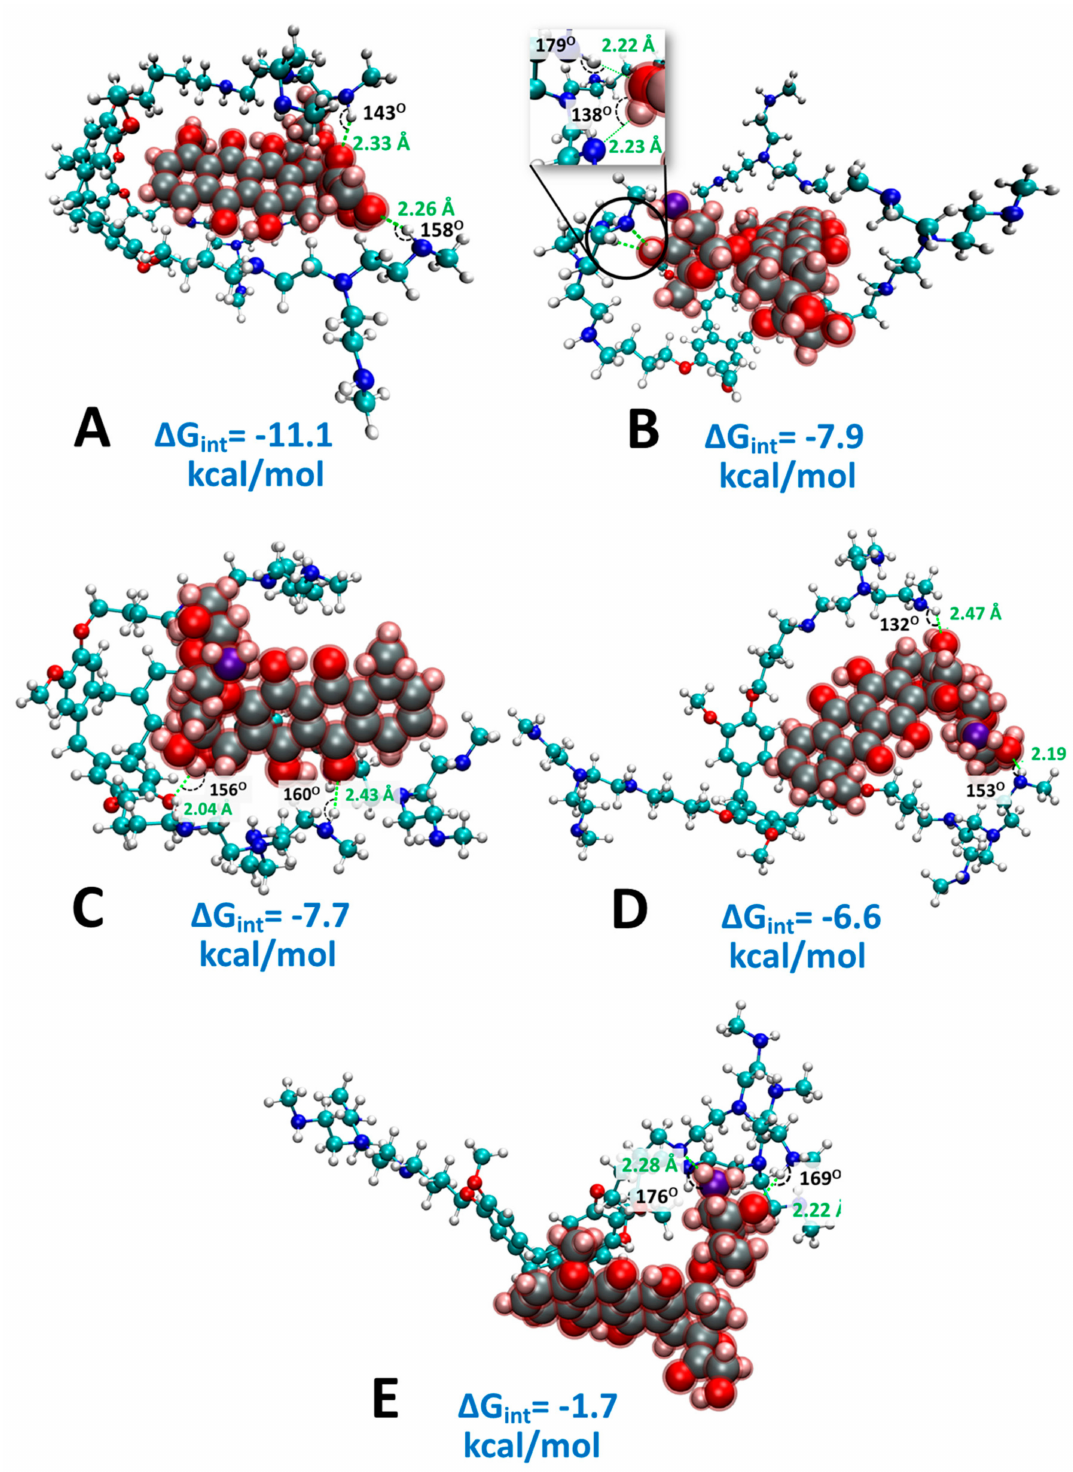
Figure 8. DFT optimized structure of the most stable configurations of doxorubicin (highlighted in light red) bound to the copolymer unit (cyan is carbon, white is hydrogen, red is oxygen, and blue is nitrogen). Hydrogen bonds between the polymer and doxorubicin are shown in green dashed lines, and the bond length in shown in green text, while the hydrogen bond angles are marked by black dashed arc and black text. ( A – E ) are some of the possible configurations considered in this paper with the corresponding polymer-doxorubicin free energy of interaction ( ∆ G int ) written in